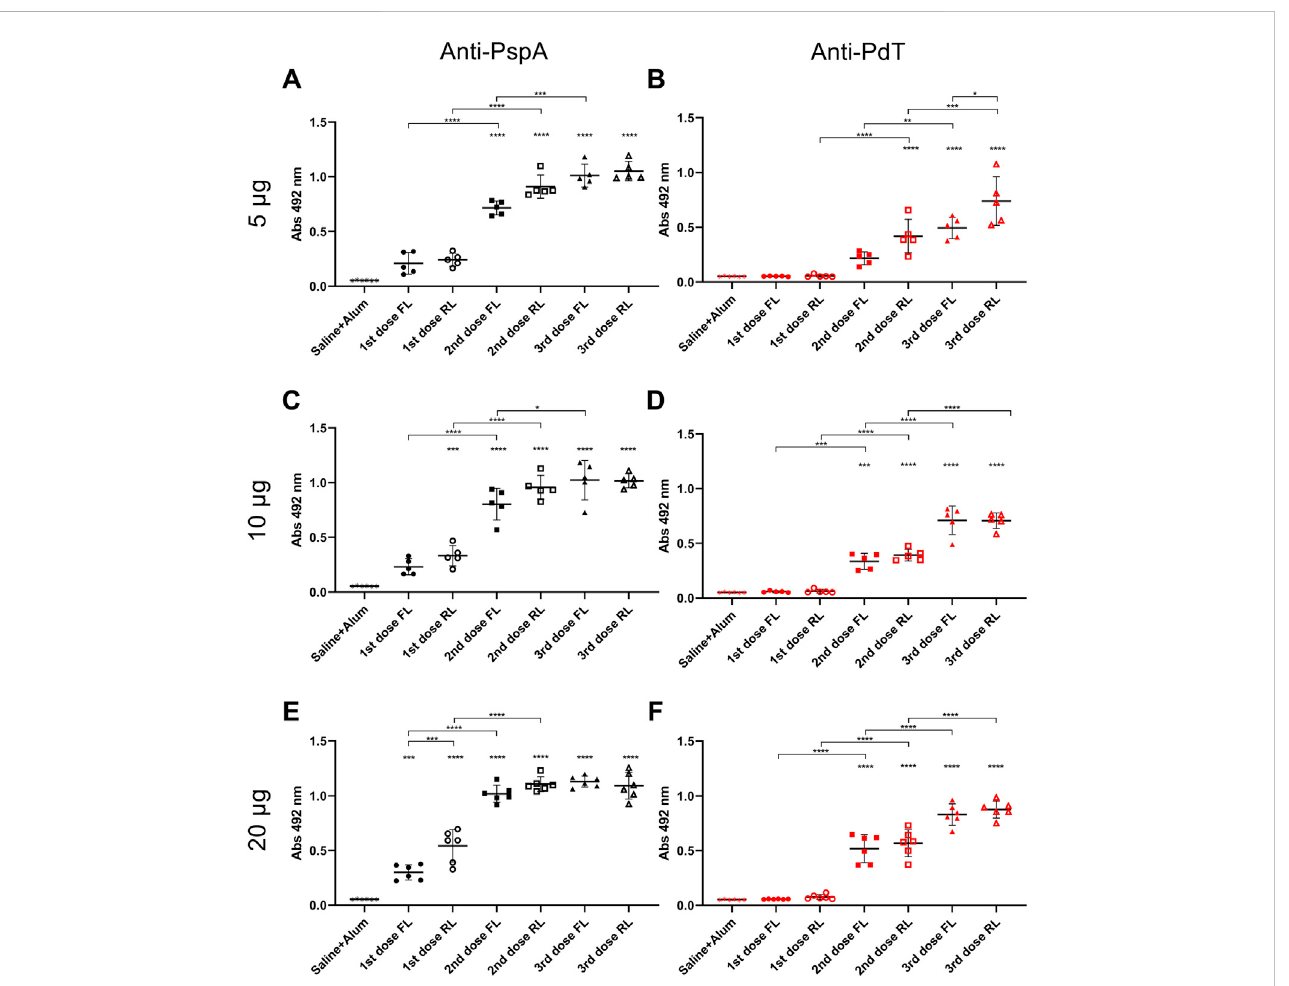
FIGURE 10 Induction of speci fi cIgG anti-rPspA and anti-rPdT by subcutaneous immunization. Mice were immunized with three doses of 5 μ g (A, B) , 10 μ g (C, D) or 20 μ g (E, F) of rPspA-FL-PdT or rPspA-RL-PdT. The animals were immunized within 15-day interval with the indicated masses or control containing only the adjuvant Alum (50 μ g) in saline. Blood was collected 14 days after each immunization and analyzed by ELISA. Antibody levels are indicated by absorbance at 492 nm of 4,000-fold diluted sera. Statistically signi fi cant differences are indicated (One-way ANOVA, Tukey ’ s Multiple Comparison Test). * p <